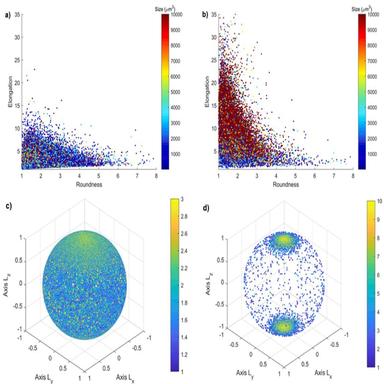
Top, void elongation versus roundness, coloured by label size, for (a) Victrex Feedstock, and (b) L&V Feedstock; bottom, unit orientation vector of void primary axis (L), coloured by elongation, for (c) Victrex Feedstock and (d) L&V Feedstock.